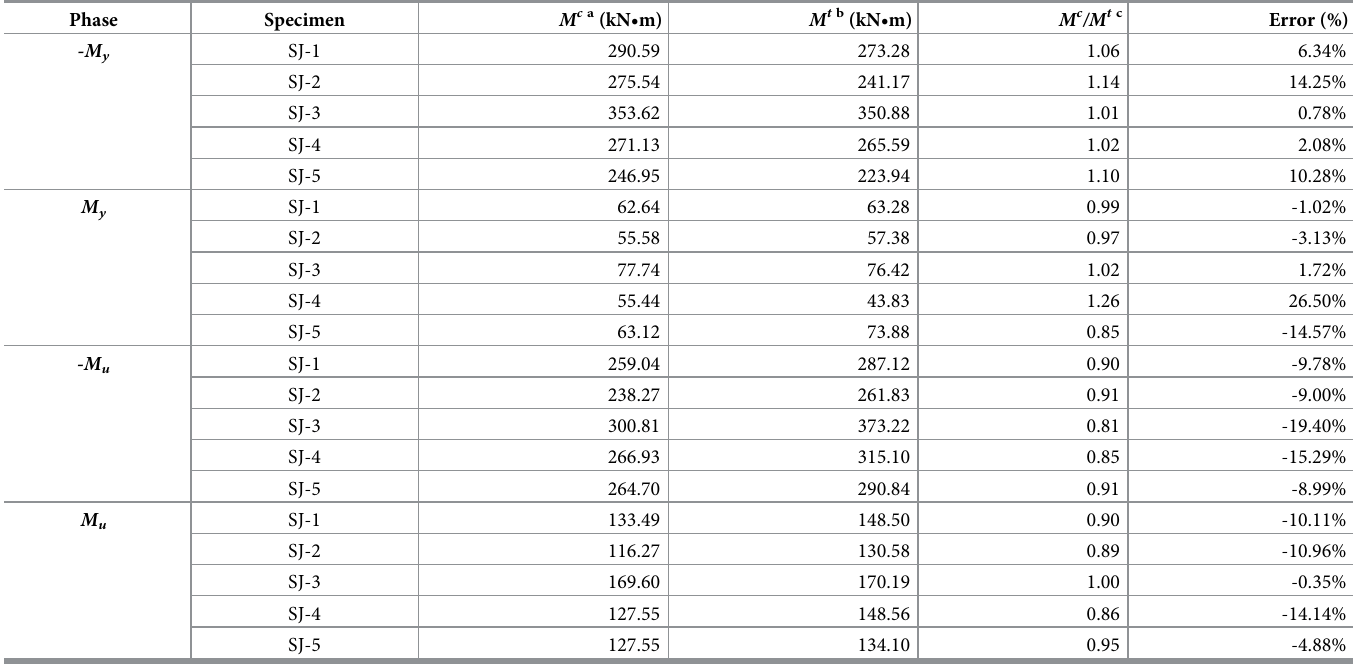
Table 5. Comparison of calculated and test